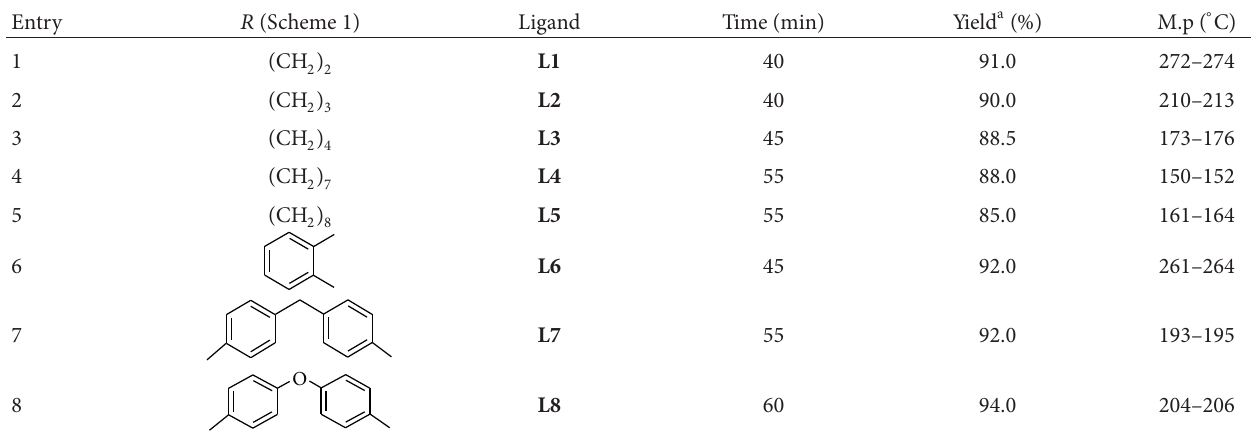
T 1: e results of the reaction for preparation of nitro-Schiff bases.